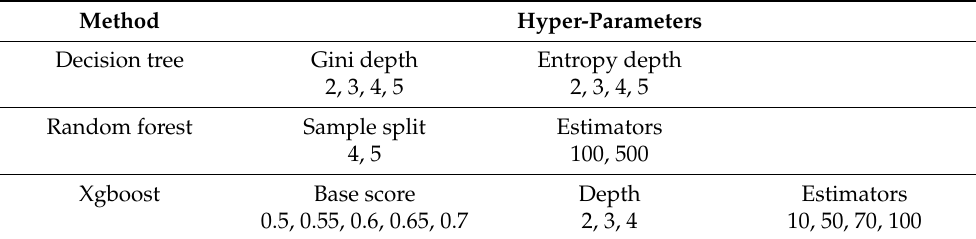
Table 3. Grid Search